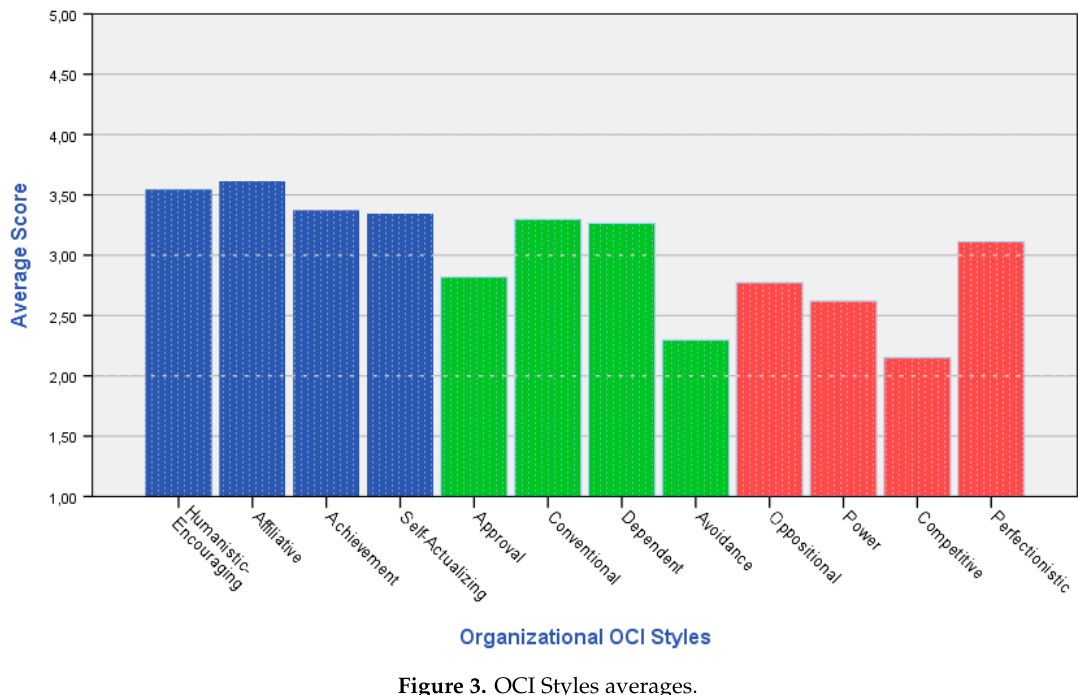
Figure 2. OCI Organizational culture averages.